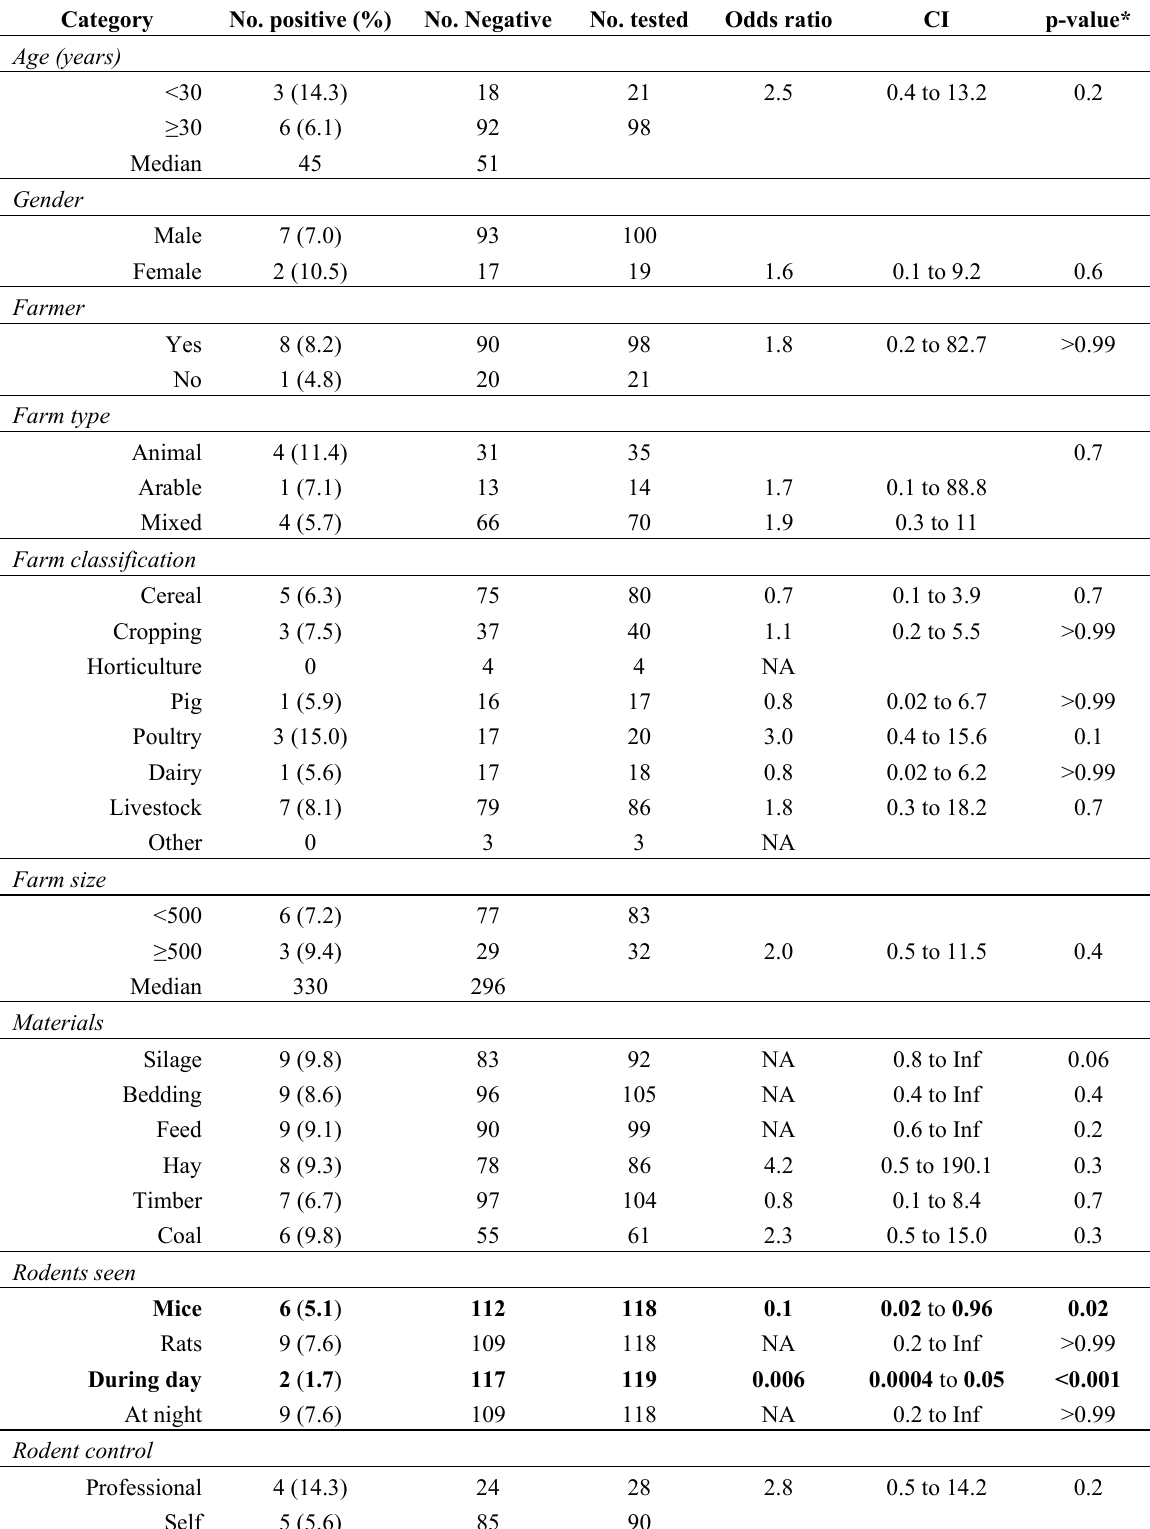
Table 2. Analysis of factors associated with seropositivity to